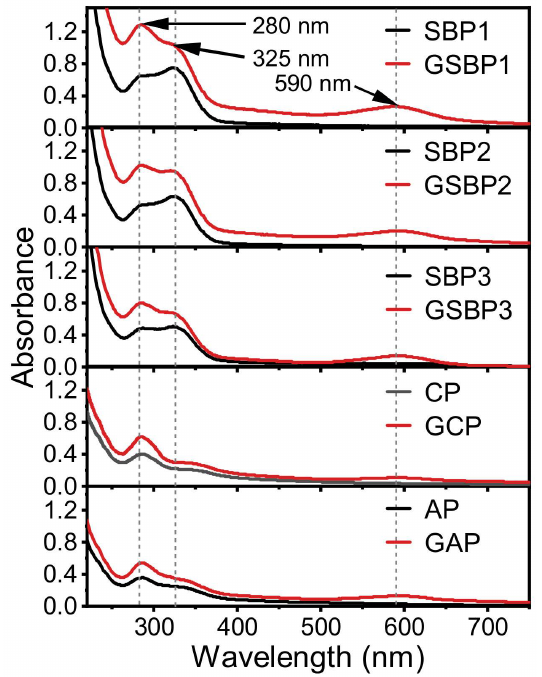
Figure 2. UV-Vis spectra of the pectin before and after genipin crosslinking